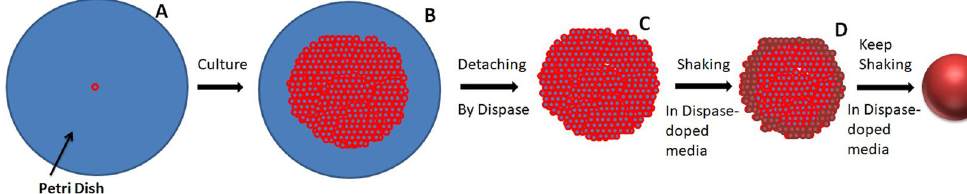
Figure 1. Cartoon illustration of cellular spheroid formation. Single cells are seeded onto petri dishes ( A ), and after a few days of growth, cell sheets form ( B ). Cell sheets can be detached from the petri dishes by dispase and the sheets can be maintained ( C ). Shaking the cell sheets in dispase-doped media allows their edges fold inward ( D ) and eventually the cell sheets become spheroids ( E